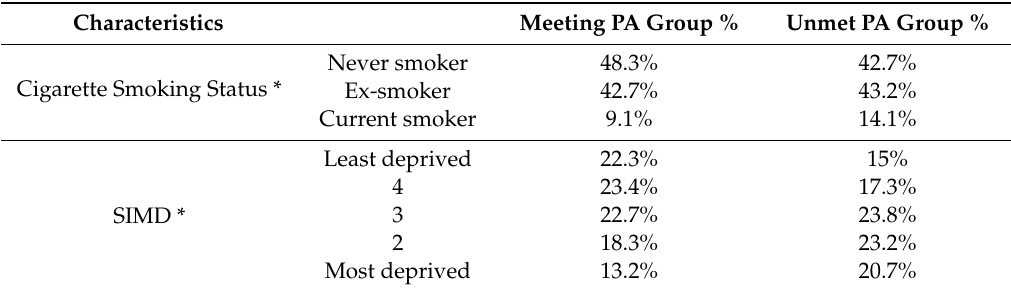
Table 3. Di ff erence of categories variables between groups.